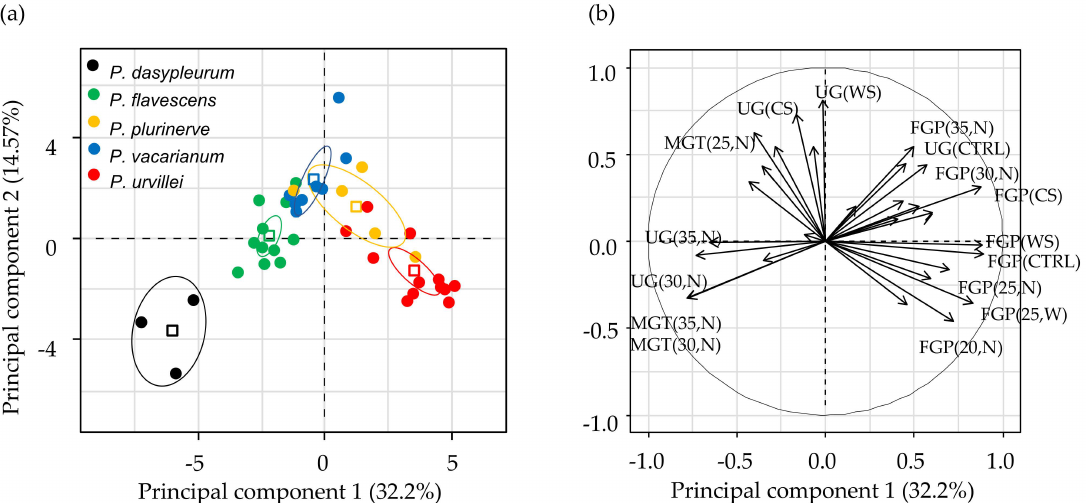
Table A5. Variance partitioning within and among species and among harvest times for first principal component (PC1) scores from PCA (see Figure A2), germination ability (GA), and germination evenness (GE). Paspalum dasypleurum was excluded from the analysis because of the absence of a genotype replica for this species.